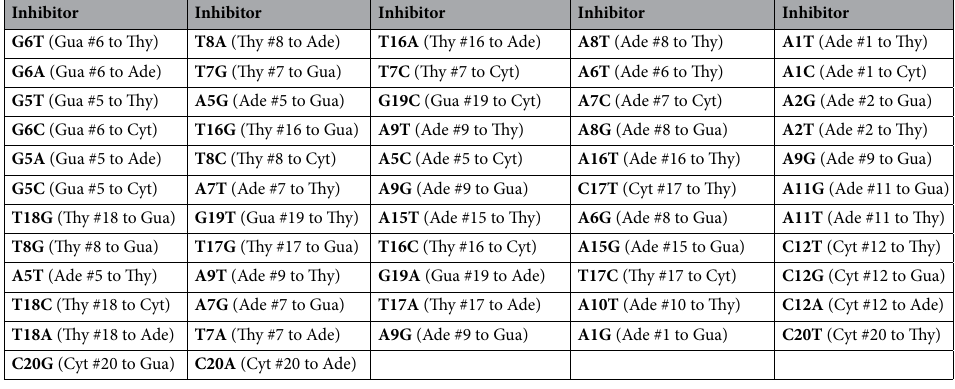
Table 10. DNA bases